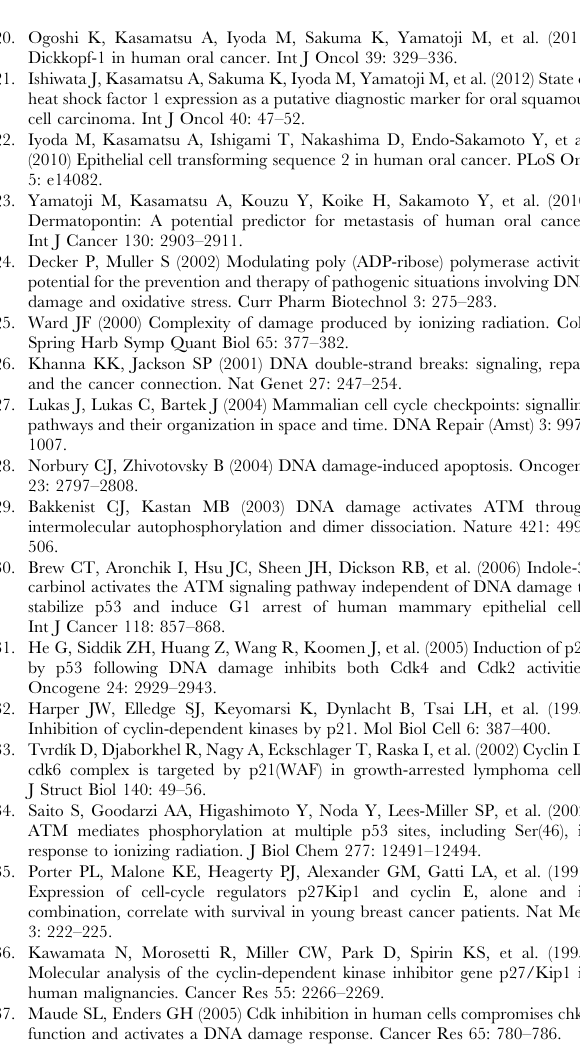
Figure S2 Quantification of protein expression in shCDCA2- and mock-transfected cells. ( A , B ) The densito- metric protein data are normalized to a -tubulin protein levels. The values are expressed as a percentage of the Mock. Western blot analysis shows up-regulation of p21 Cip1 , p27 Kip1 , p15 INK4B , and p16 INK4A and down-regulation of CDK4, CDK6, Cyclin D1 and Cyclin E in the CDCA2 knockdown cells. Figure S3 Quantification of protein expression in shCDCA2- and mock-transfected cells after CDDP treatment. ( A , B ) The densitometric protein data are normalized to a -tubulin protein levels. The values are expressed as a percentage of the Mock. Western blot analysis shows up-regulation of p-ATM, p-p53 (Ser46), and cleaved PARP-1 in the CDCA2 knockdown cells; the p53 and p-p53 (Ser15) level is unchanged. Figure S4 Evaluation of Ki-67 expression in CDCA2 negative and positive group. The percentage of cells